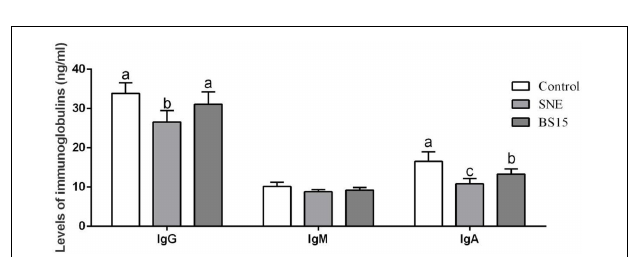
FIGURE 5 | Levels of immunoglobulins in the serum (Experiment 2). Bars with different letters are significantly different on the basis of Duncan’s multiple range tests ( P < 0.05). Data are presented as mean ± standard deviation (six replicates of one chick per cage).